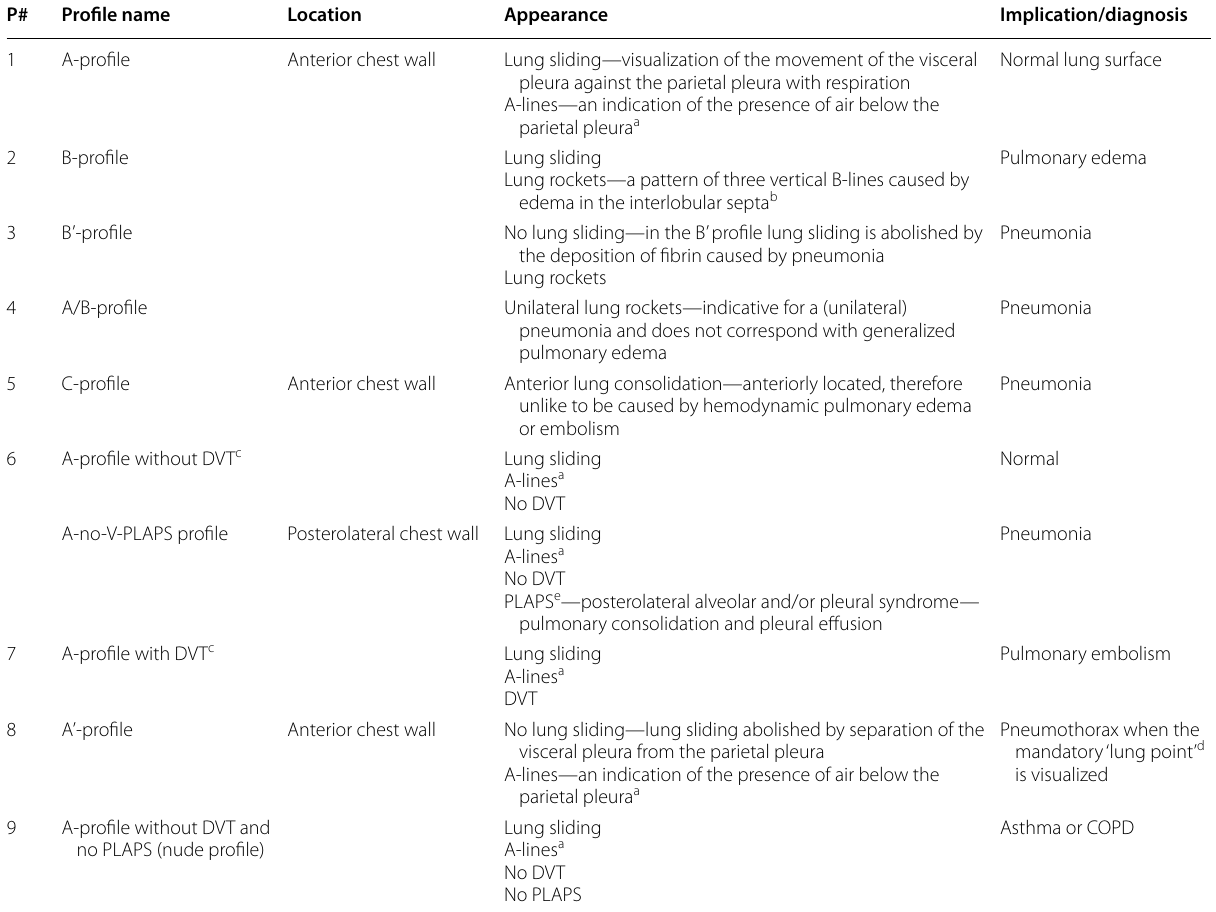
Table 1 BLUE protocol profiles. Lichtenstein